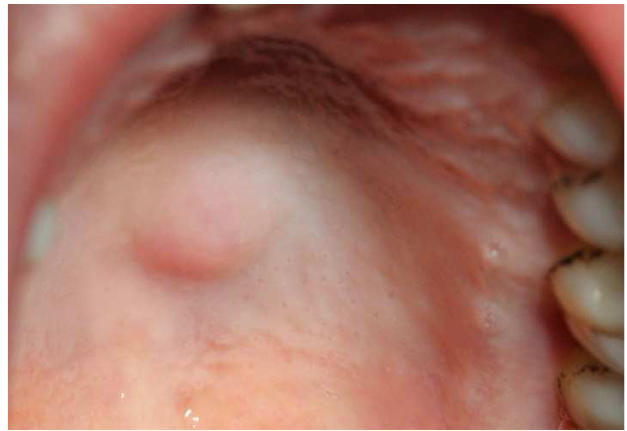
Fig. 1. Pre-operative view: well-circumscribed swelling on the left hemi palate, with a sessile base. No change of the